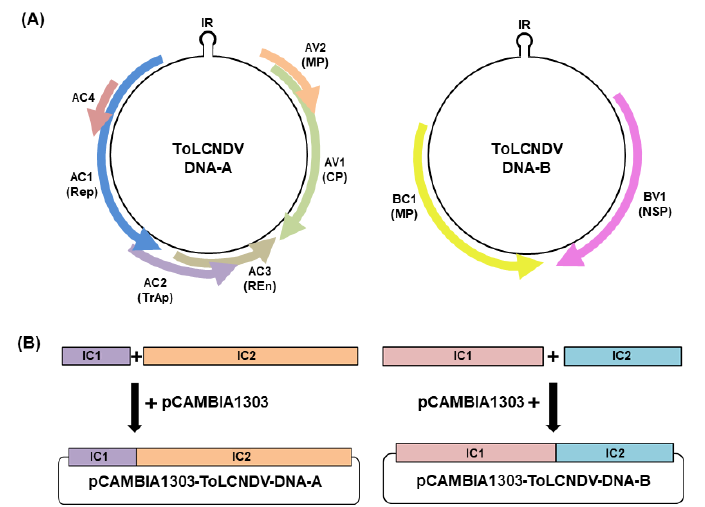
Figure 2. Genome structure and infectious clone construction of ToLCNDV. ( A ) Genome structure of DNA A and DNA B of ToLCNDV. ( B ) Scheme for ToLCNDV infectious clone construction by partial tandem repeat construction method. Two fragments of each component were generated and ligate with pCAMBIA 1303 vector to harbor a recombinant plasmid.